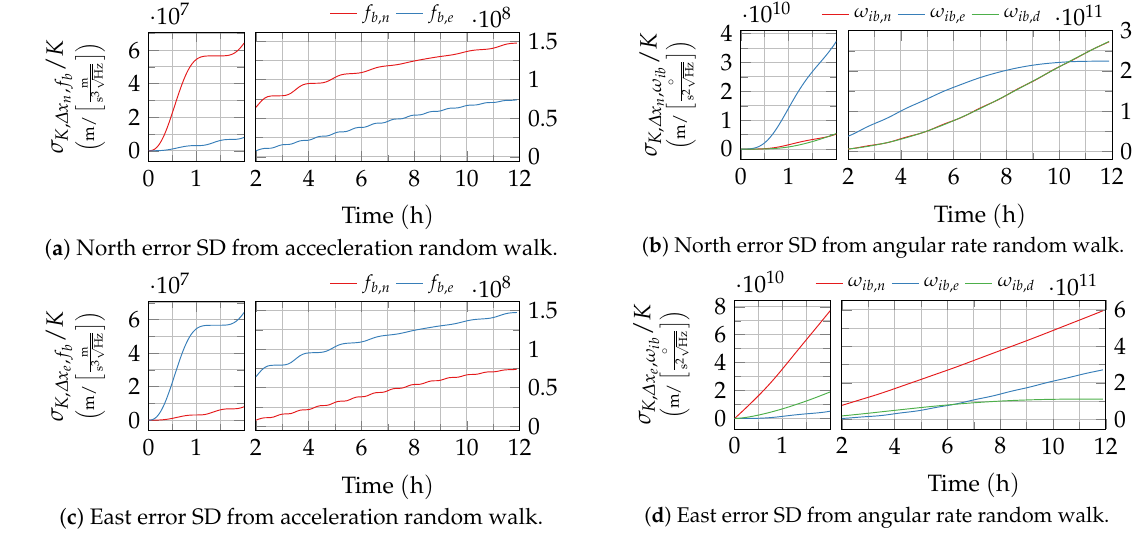
( c ) East error SD from acceleration random walk. ( d ) East error SD from angular rate random walk. Figure 5. Position error growth from rate respectively acceleration random walk noise. The time axis of the plots is split to provide a better resolution of the short-term